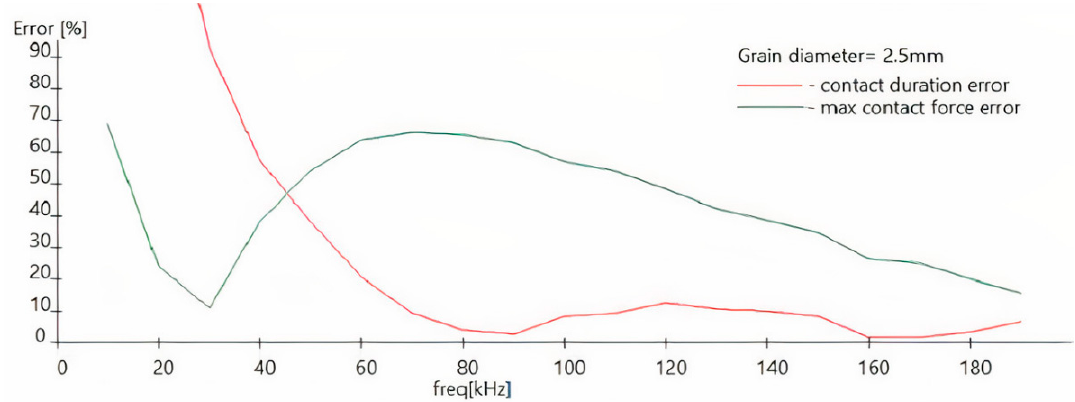
Figure 11. The error course of the contact time (red line) and the maximum impact force (green line) for grains of 2.5 mm diameter depending on the sensor resonance frequency function.